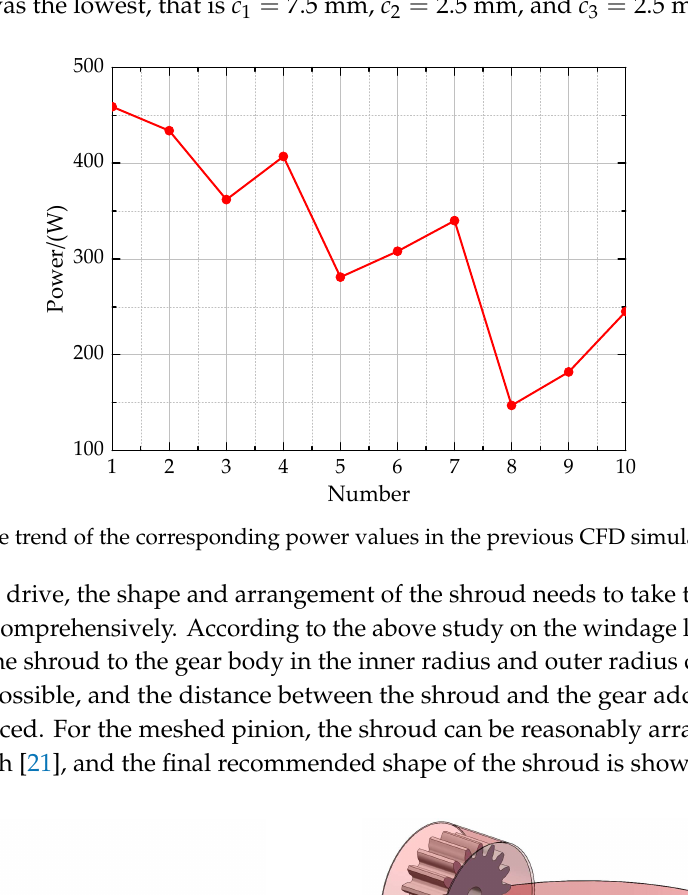
Figure 17. Change rules of static pressure along the x -axis under the different values of the distance c . 3